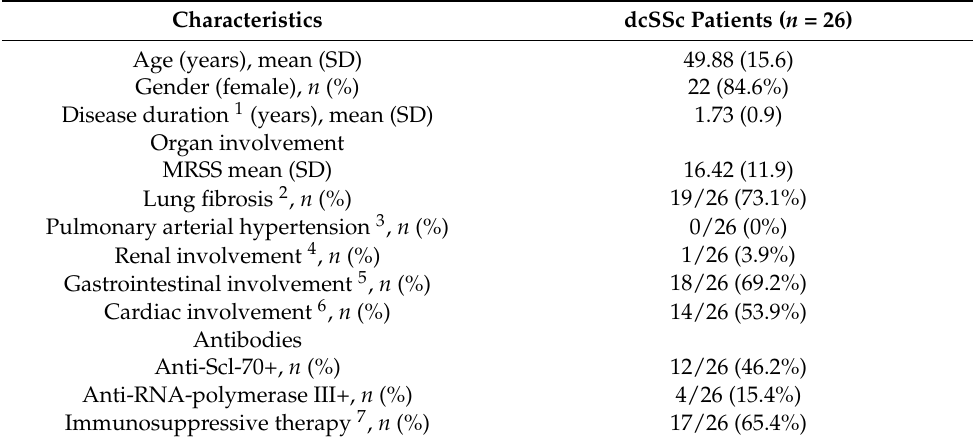
Table 1. Patients’ characteristics.